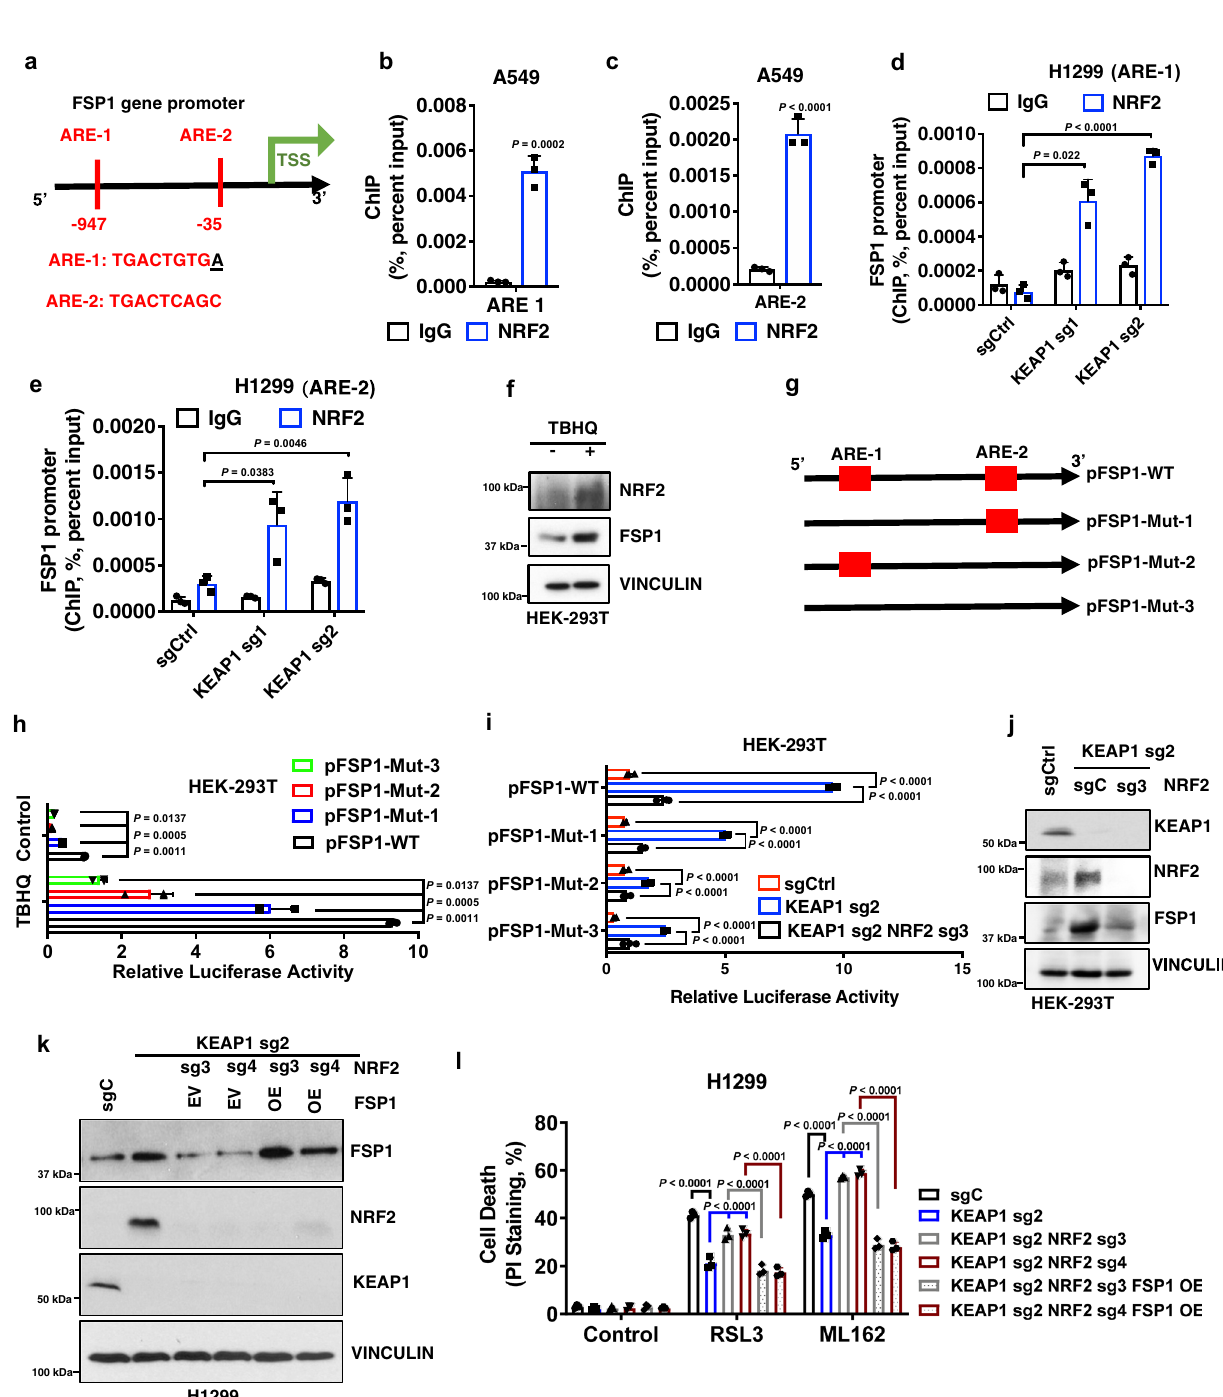
Fig. 3 KEAP1 regulates FSP1 through NRF2-mediated transcription. a Schematic showing ARE binding sites on the FSP1 promoter region. b , c ChIP analyses of NRF2 binding on ARE1 ( b ) and ARE2 ( c ) in the FSP1 promoter in A549 cells. d , e ChIP analyses of NRF2 binding on ARE1 ( d ) and ARE2 ( e ) in the FSP1 promoter in H1299 KEAP1 KO cells. f Protein levels of KEAP1, NRF2, FSP1 in HEK-293T cells treated with TBHQ. g – j FSP1 promoter-luciferase activities in response to TBHQ treatment ( g , h ) or in KEAP1 NRF2 DKO HEK-293T cells ( i , j ). k Protein levels of KEAP1, NRF2, and FSP1 in KEAP1 NRF2 DKO H1299 cells overexpressing FSP1. EV empty vector, OE overexpression. l PI staining to measure cell death upon RSL3 or ML162 treatment in KEAP1 NRF2 DKO H1299 cells overexpressing FSP1. Data were presented as (if mentioned otherwise) mean ± SD; n = 3. P value was determined by unpaired Student ’ s t -test (3 b – e ) and two-way ANOVA (3 h , i , l ); ns not signi fi cant. Source data are provided as a Source Data fi